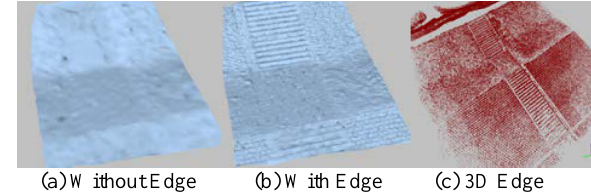
Figure 11 Measurement result of stair-case